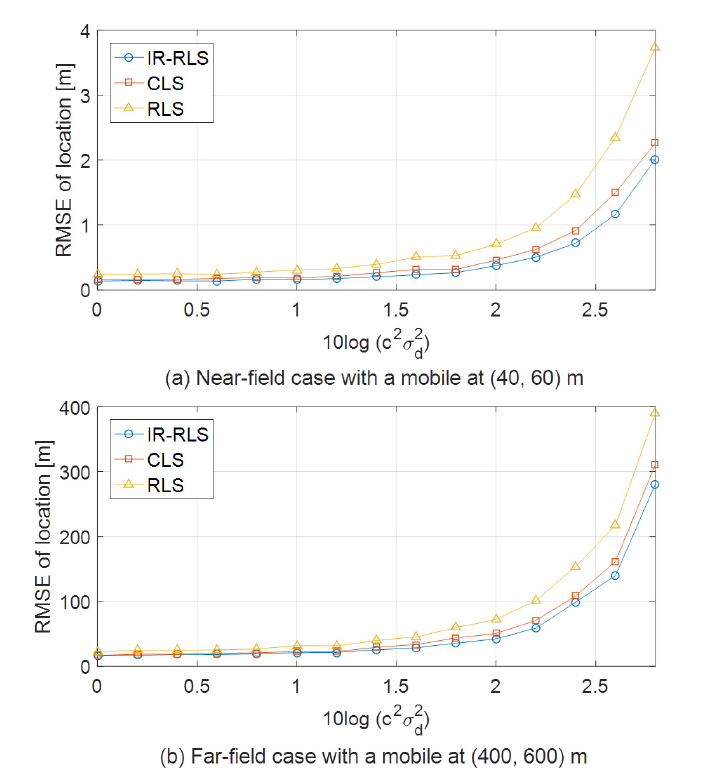
Figure 4. Estimation comparison for near-field and far-field mobile cases.